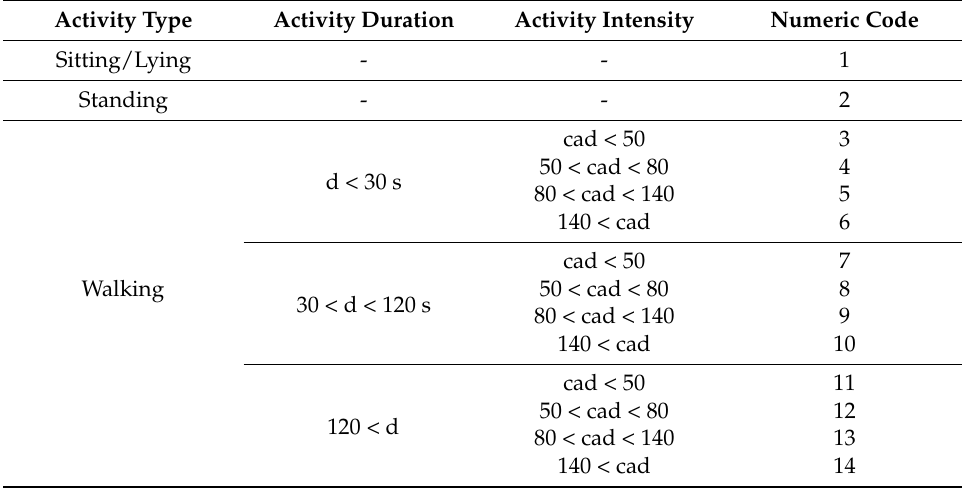
Table 1. Coding activities based on duration and intensity thresholds; d: duration, cad: cadence.